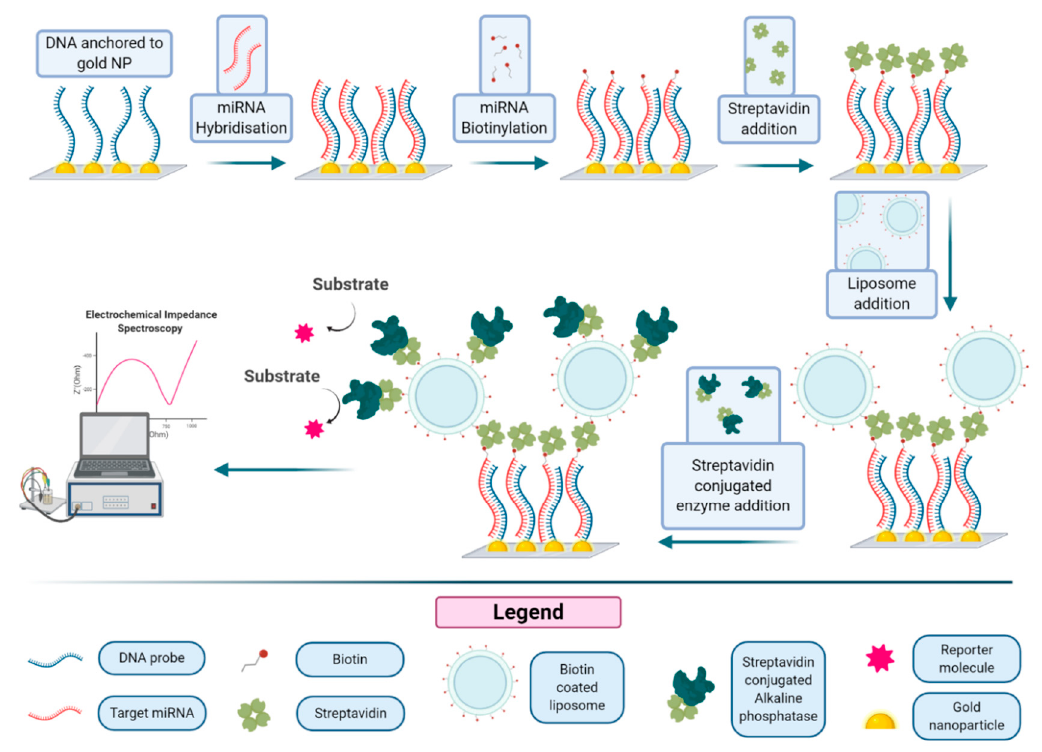
Figure 8. Biotinylated liposome amplification for the detection of micro-RNA: single-stranded DNA probes are bound to the surface of gold nanoparticles, and made to interact with the miRNA of interest, which is subsequently biotinylated. A biotinylated liposome is then anchored to the miRNA through a streptavidin molecule, and further recognized by streptavidin-tagged enzyme. The signal obtained by the enzyme–substrate interaction is then quantified. Figure inspired by [61].